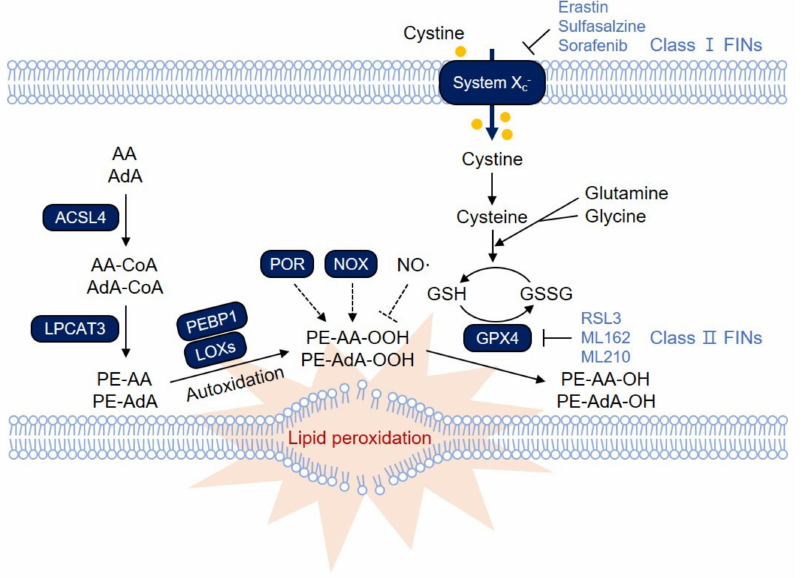
Figure 1. The ferroptosis signaling pathway. Polyunsaturated fatty acids (PUFAs) in membrane phospholipids undergo lipid peroxidation, which directly destroys the cellular membrane, thereby causing necrotic cell death via ferroptosis. Glutathione Peroxidase 4 (GPX4) reduces lipid peroxide to lipid alcohol by oxidizing glutathione (GSH), thereby protecting cells from ferroptosis under normal conditions. Inactivation of GPX4 or depletion of GSH therefore leads to massive lipid peroxidation and induces ferroptosis. Ferroptosis-inducing compounds (FINs) are categorized into two main groups: those that inhibit system x c − , thereby depleting GSH levels (class I FINs), and those that directly inhibit GPX4 (class II FINs). Among various membrane phospholipids, arachidonic acid (AA)- and adrenic acid (AdA)-containing phosphatidylethanolamine (PE) and phosphatidylcholine (PC) are the primary targets for lipid peroxidation. Acyl-CoA synthetase long-chain family member 4 (ACSL4) links free PUFAs to CoA, generating fatty acyl-CoA esters, which are eventually incorporated into PC/PE by lysophosphatidylcholine acyltransferase 3 (LPCAT3). PE-AA and PE-AdA can be oxidized by lipoxygenases (LOXs). LOX might require phosphatidylethanolamine-binding protein 1 (PEBP1) to induce lipid peroxidation on the membrane. In addition, other oxygenases, such as NADPH oxidases (NOXs) and cytochrome P450 oxidoreductase (POR), are known to contribute to lipid peroxidation. Lipid peroxidation is also mediated by nonenzymatic autoxidation, which is suggested to be the ultimate driver of ferroptotic cell death. In contrast, NO • reacts with lipid peroxyradicals, thereby attenuating lipid peroxidation and